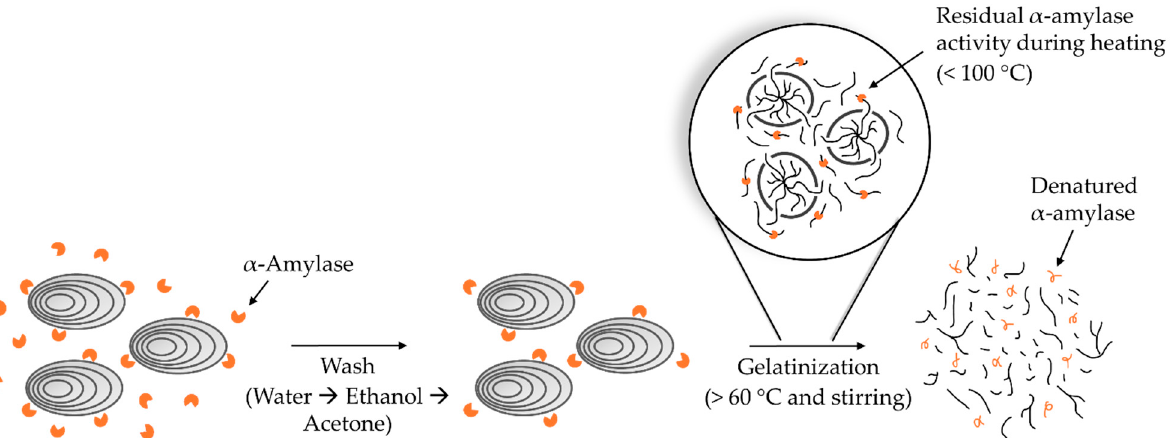
Figure 3. Illustration of how inefficient removal of α -amylase (orange Pac-Man) during the washing steps paves the way for residual hydrolytic activity during subsequent gelatinization of raw potato starch. potato